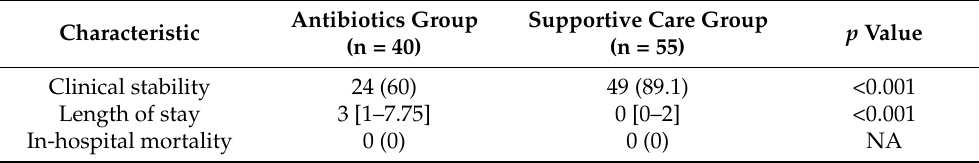
Table 2. Outcomes of